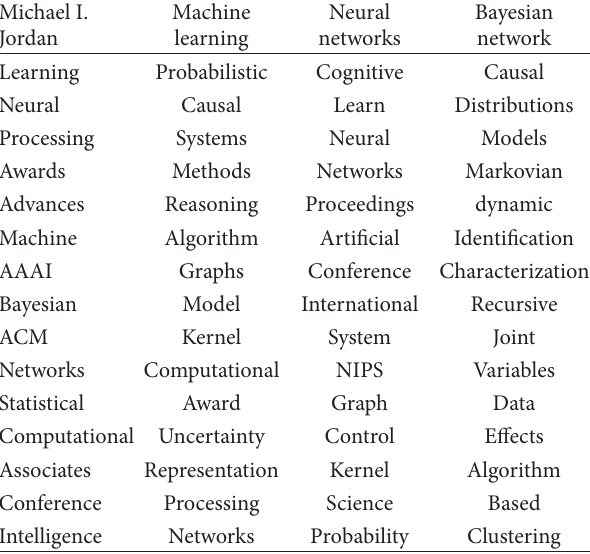
Table 3: Michael I. Jordan’s entity prior ( 𝜑 𝑒 ) and word distributions ( 𝜑 𝑒,𝑧 ) of his research topics.